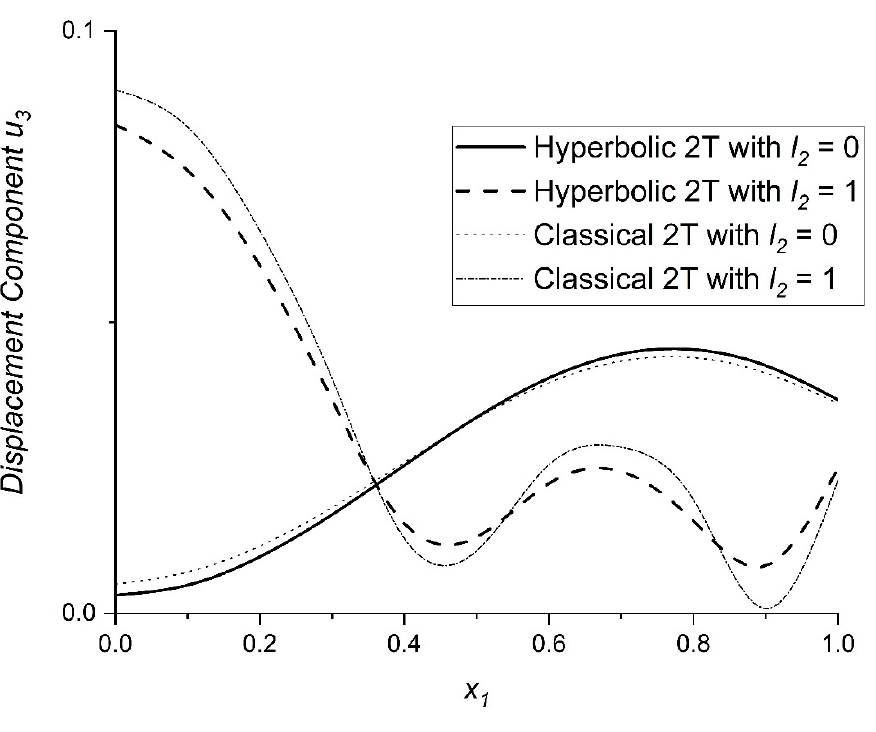
Figure 4. Variations in dimensionless displacement component u 3 .